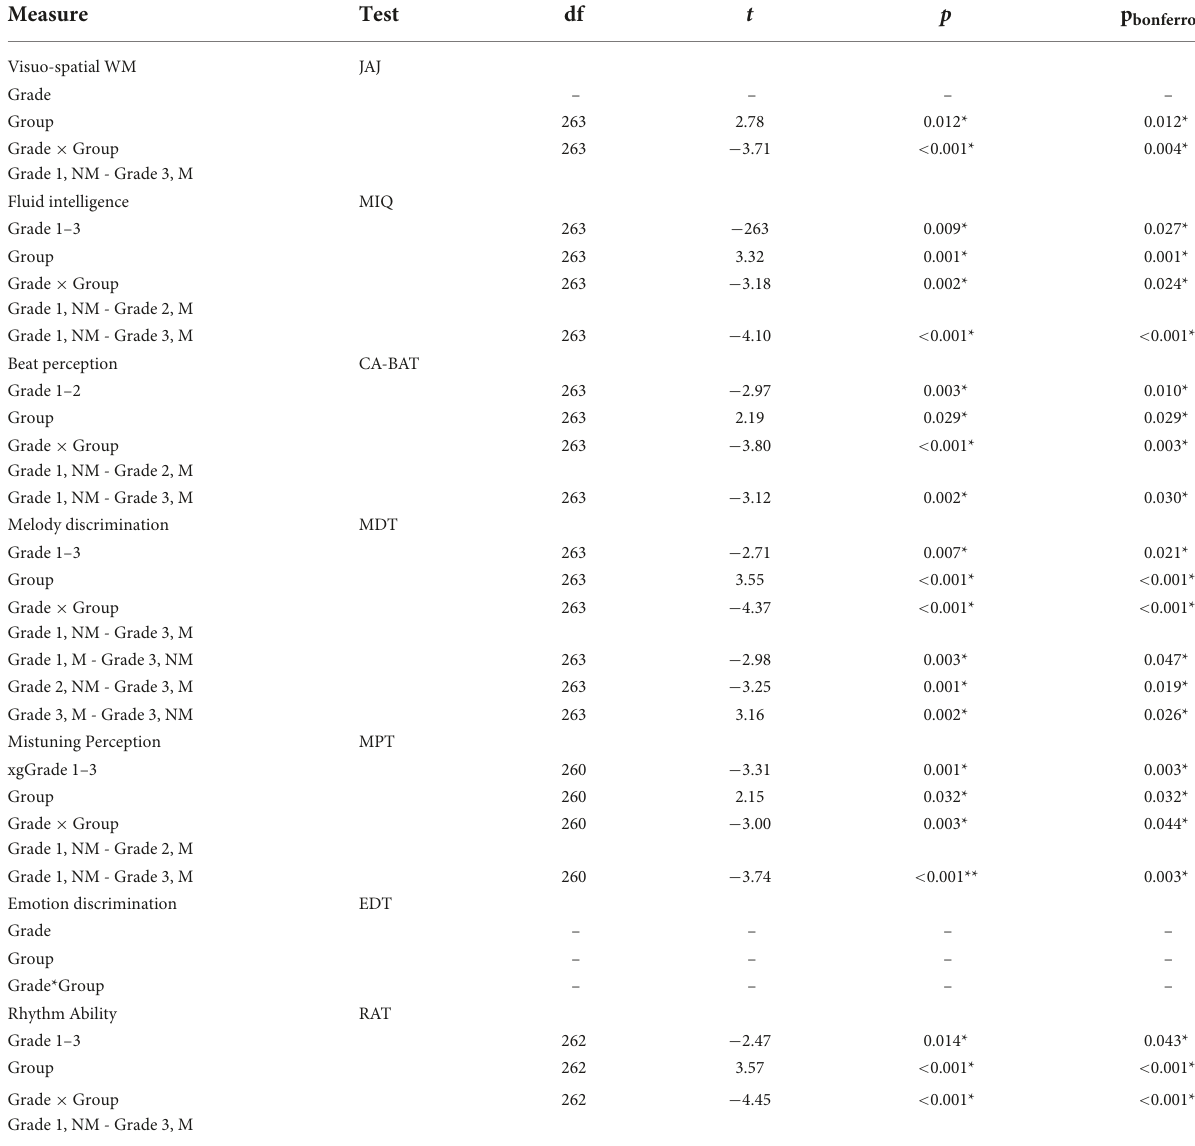
TABLE 8 ANCOVA’s post hoc comparison (Bonferroni correction) for grade, group and grade × group